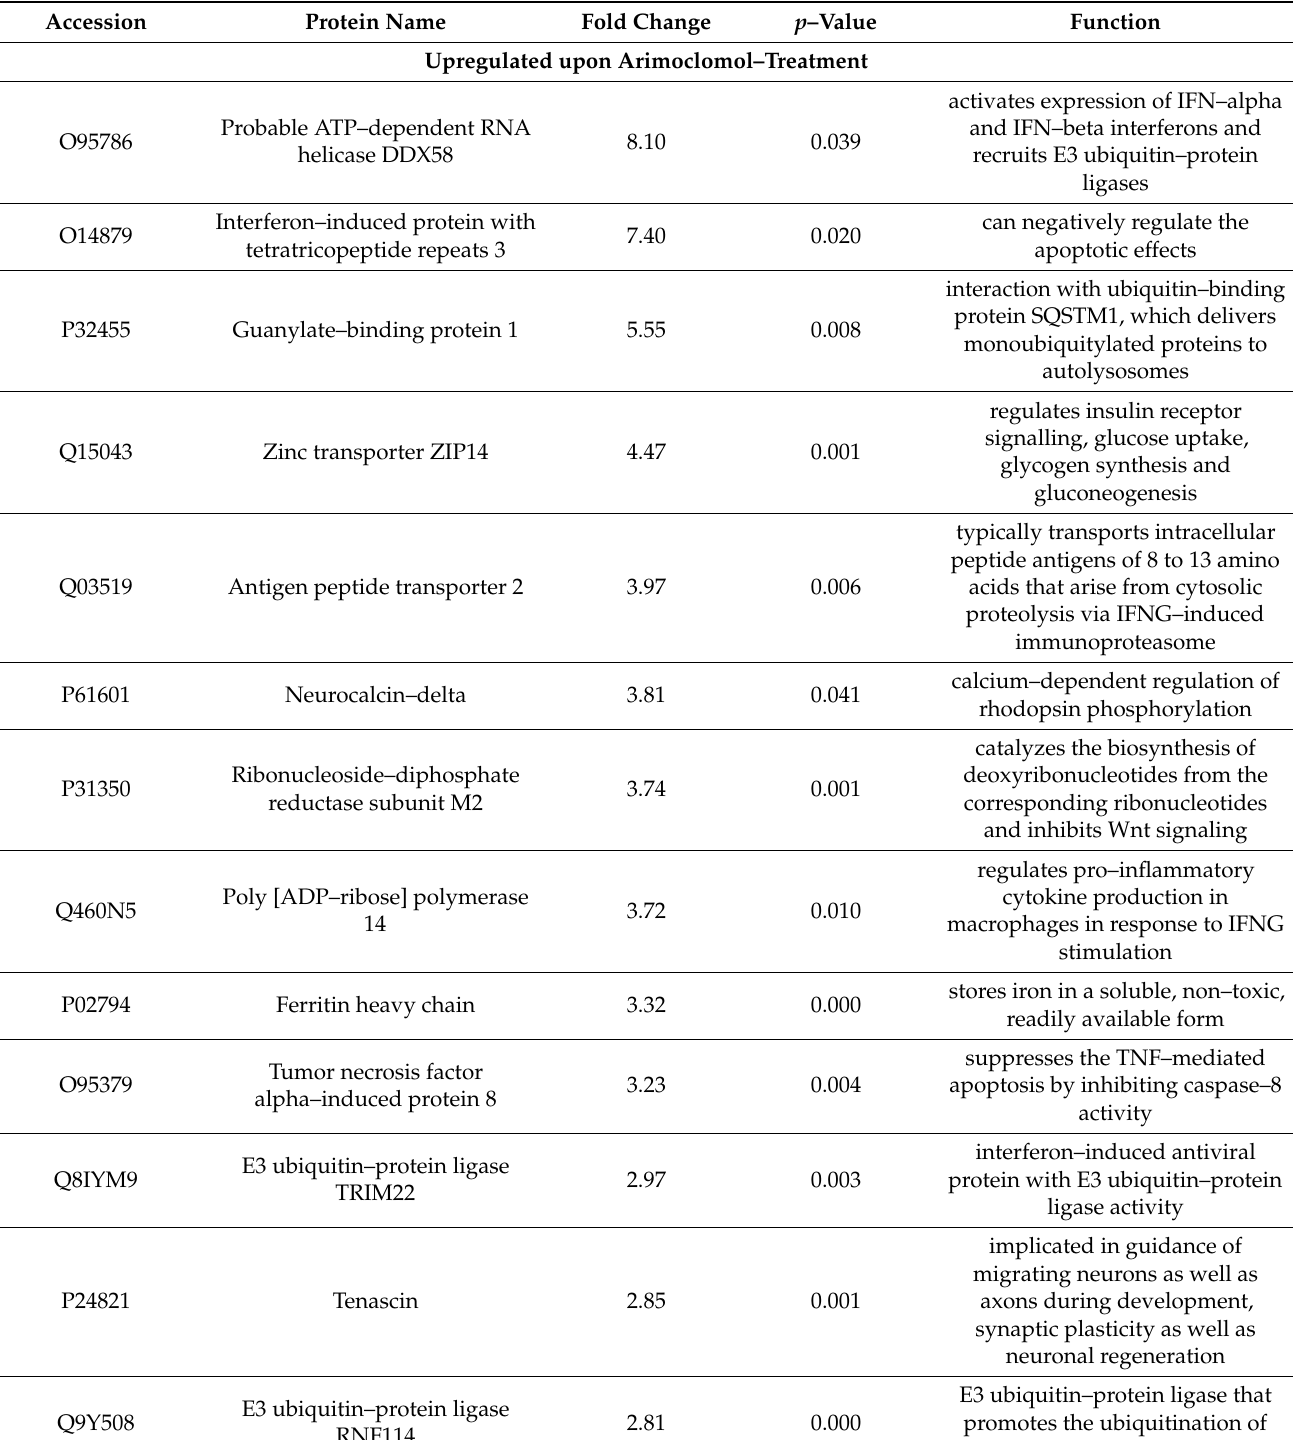
Table 2. List of up– and downregulated proteins in VCP –mutant fibroblasts treated with arimoclomol. The term entry reflects UniProt identification